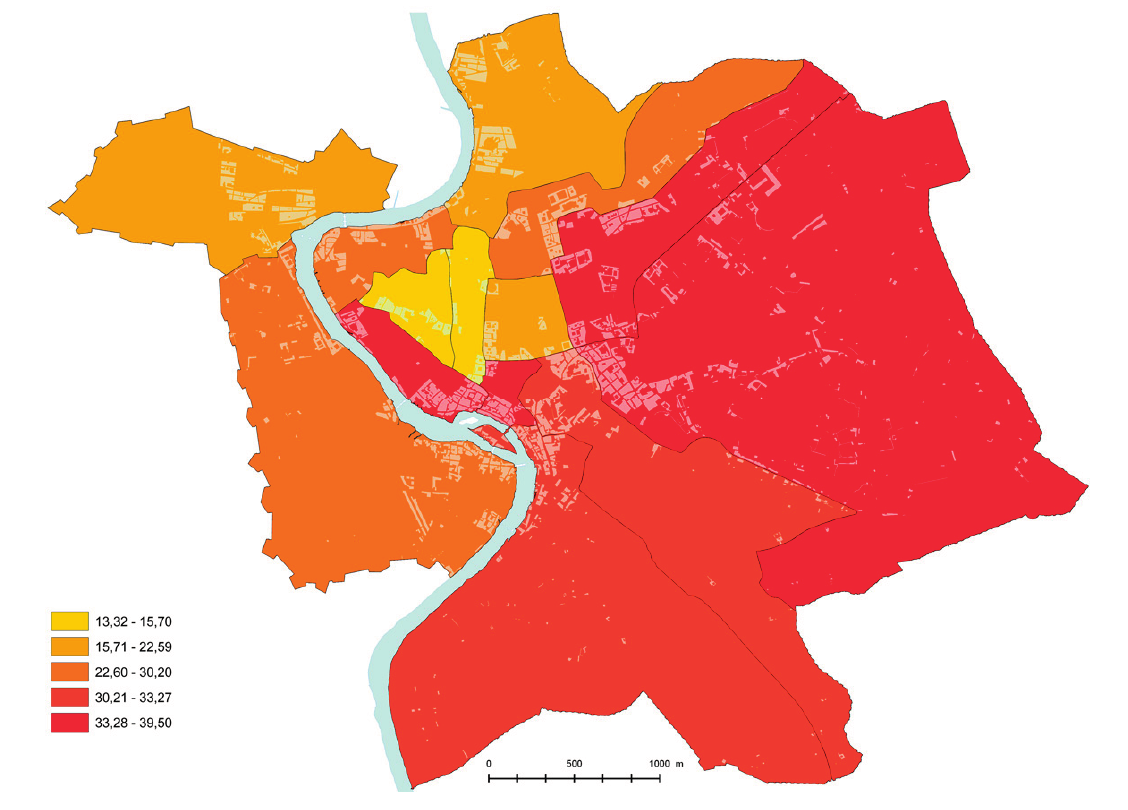
Figure 10. Lost urban heritage (%) in the Rioni (quarters) of Rome. Demolished building blocks are evidenced in light